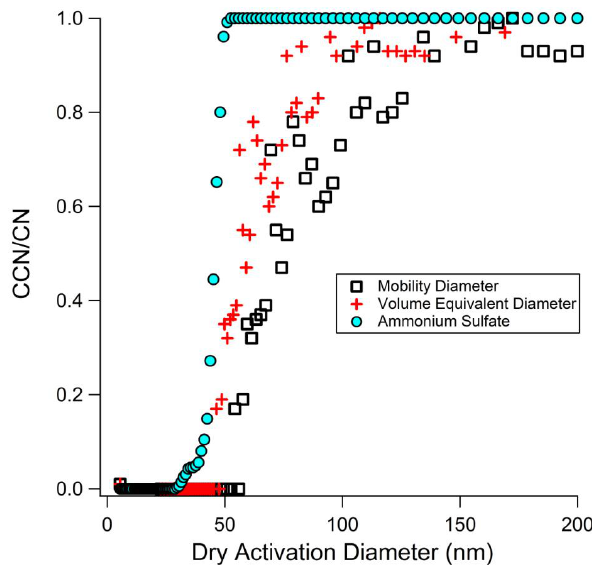
Figure 6: Activation curves for manzanita using the mobility diameter and the volume equivalent diameter calculated using the shape factor data from Fig. 4. The activation curve of ammonium sulfate is included for comparison. The black squares represent the raw electrical mobility activation diameters and the red crosses are the volume equivalent diameters.